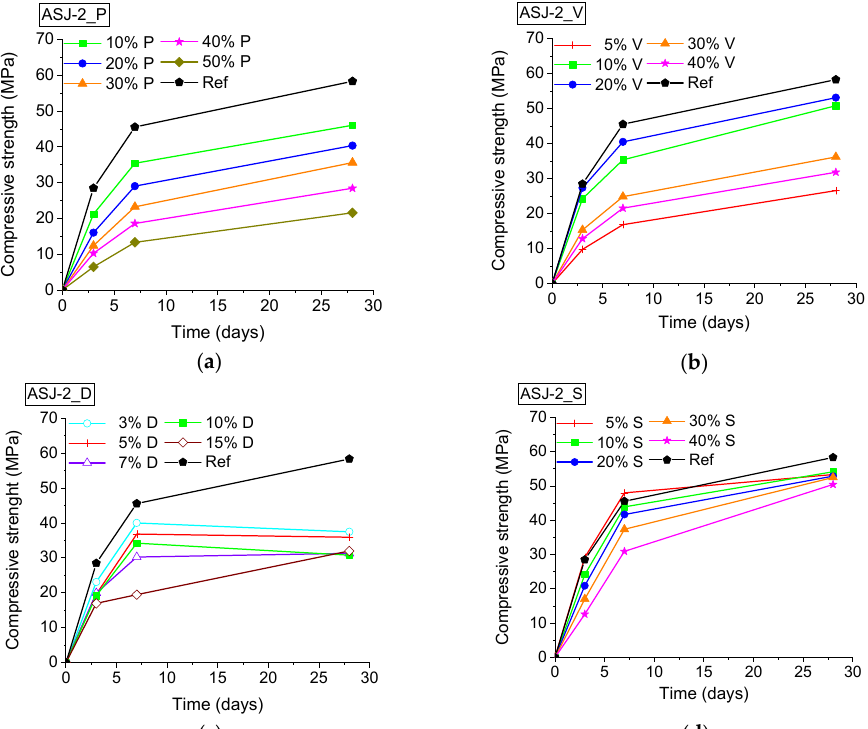
Figure 2. Compressive strength results of the mortars made with the non-reactive siliceous sand, ASJ_2, and four additions mixed in four percentages of 20%, 30%, 40% and 50%: ( a ) natural pozzolan, P; ( b ) siliceous coal fly ash, V; ( c ) silica fume, D; ( d ) blast-furnace slag, S.